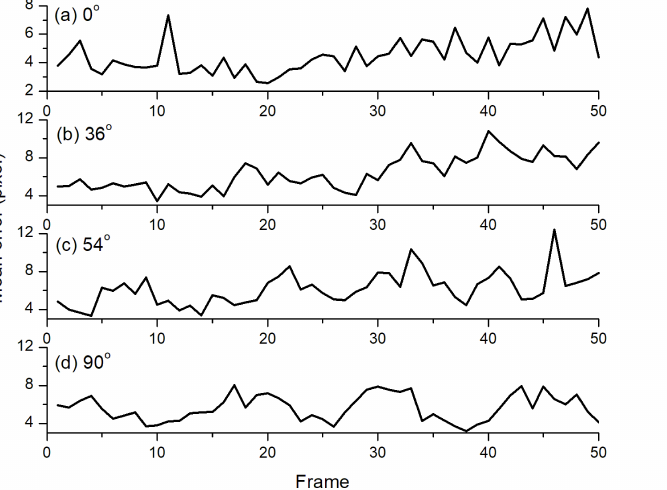
Figure 15. Mean fit error for each frame in the CAISA Gait collection for pedestrians walking at ( a ) 0 degrees, ( b ) 36 degrees, ( c ) 54 degrees, and ( d ) 90